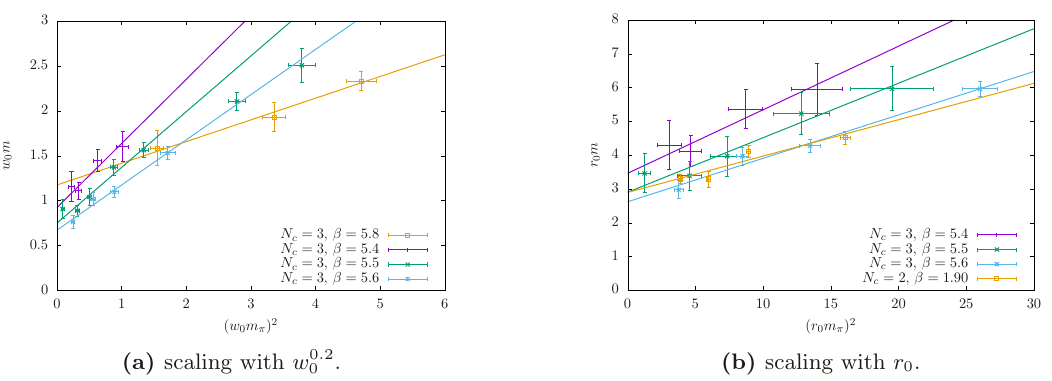
Figure 11. A comparison of the gluino-glue mass in units of the Sommer scale r 0 and of w 0 . 2 different lattice spacings (corresponding to different β ) and SU( N c ) gauge groups as a function of the squared adjoint pion mass. The simulations of SU(3) SYM at β = 5 . 4, 5 . 5, 5 . 6, and 5 . 8 have been done with a clover improved fermion action and a plain Wilson gauge action; the simulations of SU(2) SYM at β = 1 . 9 with a plain Wilson fermion action, one level of stout smearing, and a tree level Symanzik improved gauge